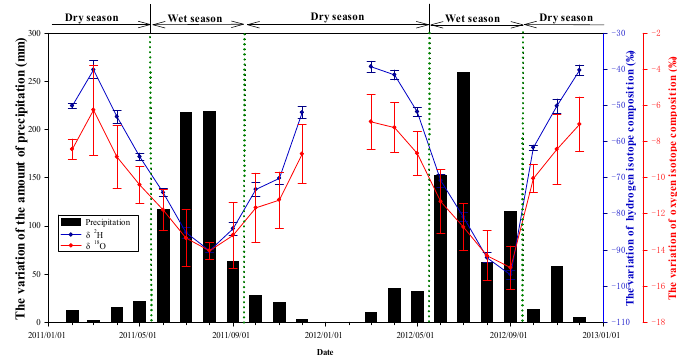
Figure 2. The variation of the amount of precipitation and its isotopic compositions in the study area.